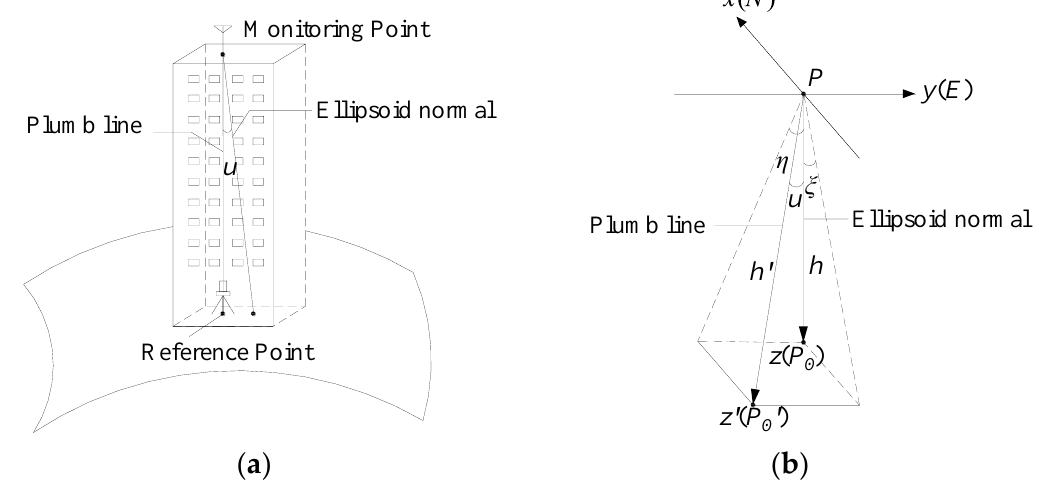
Figure 3. Difference between the Global Navigation Satellite System (GNSS) measurement and laser plumbing. ( a ) The relationship between plumb line and ellipsoid normal during monitoring; ( b ) Decomposition of the deflection of the vertical u